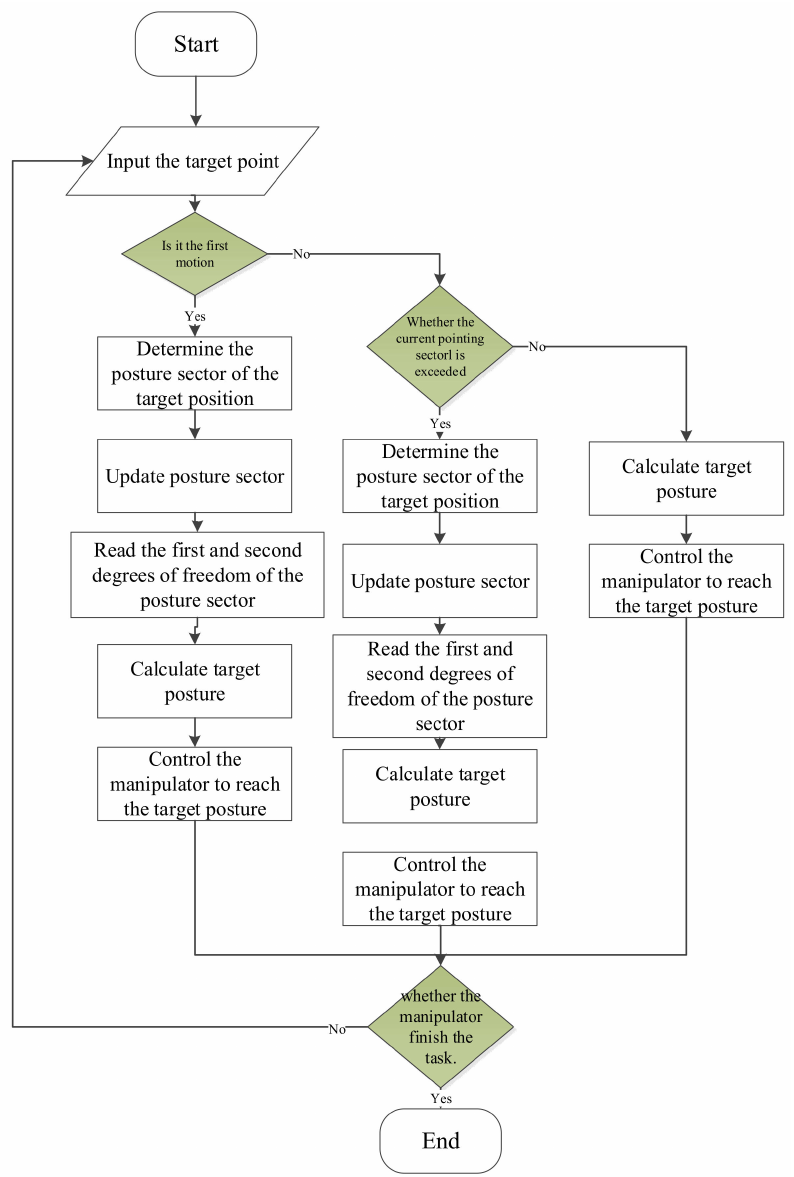
Figure 10. Flow chart of path planning